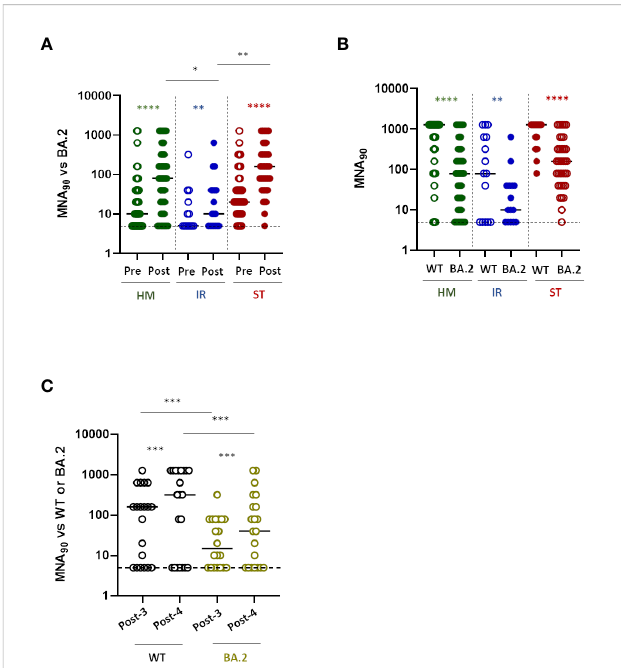
FIGURE 2 Neutralization response to the fourth dose of mRNA vaccine in fragile patients (A) The levels of neutralizing antibodies were quanti fi ed by microneutralization assay (MNA 90 ) against Omicron BA.2 in HM (green dots), IR (blue dots) and ST (red dots) before (pre) and after (post) the fourth dose of mRNA vaccine. The MNA 90 was measured only in patients showing a positive anti-RBD response. The results were expressed as reciprocal of dilution and values >5 are considered positive. HM-pre median= 10 reciprocal of dilution (IQR 5-40); HM- post median=80 reciprocal of dilution (IQR 10-320). IR-pre median= 5 reciprocal of dilution (IQR 5-30); IR-post median= 15 reciprocal of dilution (IQR 5-40). ST-pre median= 20 reciprocal of dilution (IQR 10- 80); ST-post median= 160 reciprocal of dilution (IQR 50-320). Differences between MNA 90 titre before and after the fourth dose within the same group were evaluated by Wilcoxon paired test, while differences across groups were evaluated by Kruskal-Wallis. ****P<0.0001; **P<0.01. (B) The levels of neutralizing antibodies against wild-type (WT) and BA-2 Omicron (BA.2) strains after the fourth dose of mRNA vaccine were compared in HM (green dots), IR (blue dots) and ST (red dots). The results were expressed as reciprocal of dilution and values >5 are considered positive. HM-WT median=1280 reciprocal of dilution (IQR 80-1280); HM-BA.2 median=80 reciprocal of dilution (IQR 10-320). IR-WT median= 80 reciprocal of dilution (IQR 5-640); IR-BA.2 median= 10 reciprocal of dilution (IQR 5-40). ST-WT median= 1280 reciprocal of dilution (IQR 640-1280); ST-BA.2 median= 160 reciprocal of dilution (IQR 40-320). Differences were evaluated by Kruskal-Wallis test. ****P<0.0001; ** P<0.01. (C) The levels of neutralizing antibodies against wild-type (WT) and BA-2 Omicron (BA.2) strains after 10-20 days from the third (post- 3) and fourth (post-4) dose of mRNA vaccine were compared in a subgroup of patients (n=21). The results were expressed as reciprocal of dilution and values >5 are considered positive. WT-post-3 median=160 reciprocal of dilution (IQR 5-520); WT-post-4 median= 320 reciprocal of dilution (IQR: 5-1280). BA.2-post-3 median= 15 reciprocal of dilution (IQR 5-80); BA.2-post-4 median= 40 (IQR 5- 240). Differences between neutralization titre against WT and BA.2 after the third and fourth dose evaluated by Wilcoxon paired test ***P<0.001. HM, hematological malignancies; IR, immune- rheumatological diseases; ST, solid